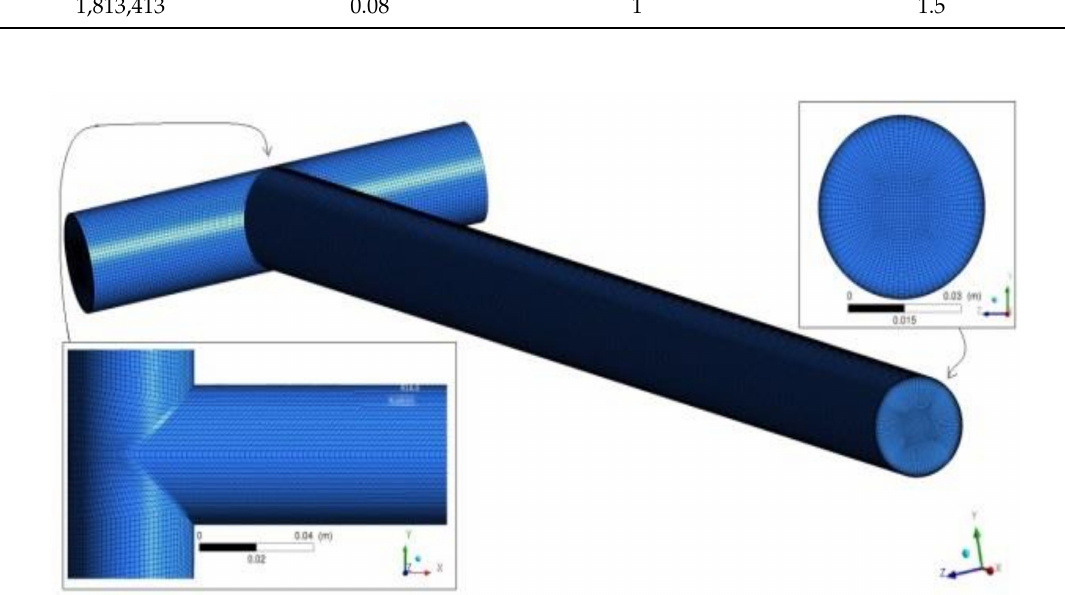
Figure 6. O-grid discretized